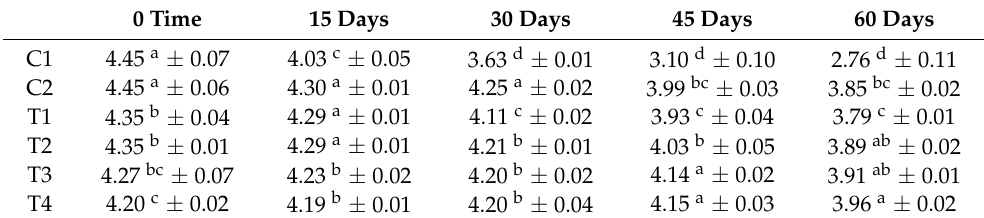
Table 6. Changes in pH values of the mayonnaise samples enriched with the RCFE during storage.